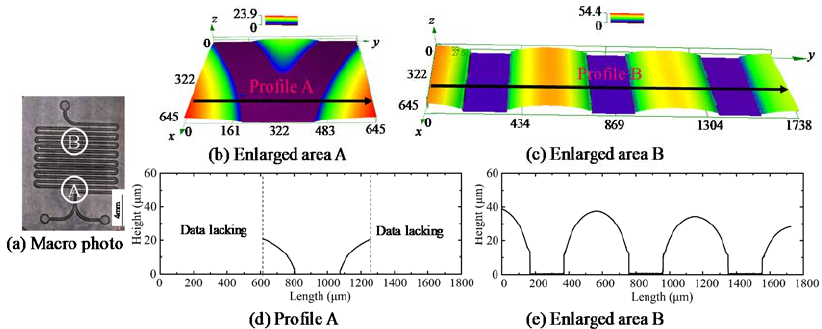
Figure 10. The microstructure of the molded diffusion mixer chip (550 °C, 0.5 MPa). ( a ) Marco photo; ( b ) Enlarged area A; ( c ) Enlarged area B; ( d ) Profile A; ( e ) Enlarged area B.